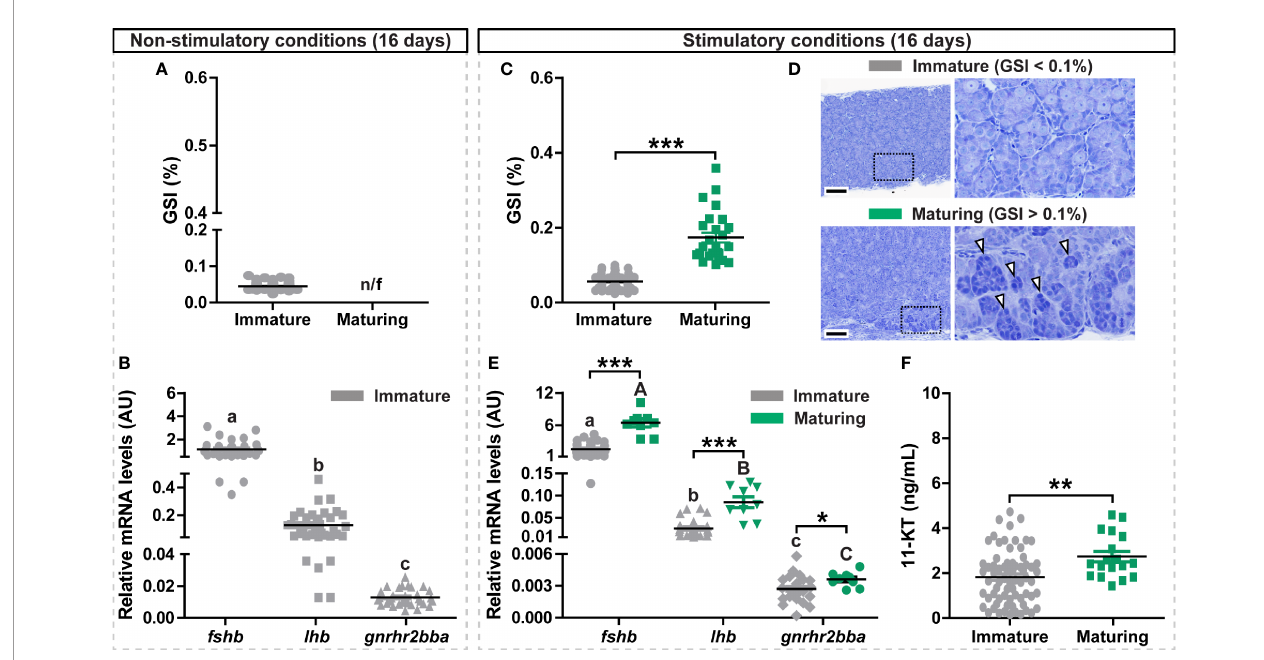
FIGURE 1 | Evaluation of gonadal and pituitary responses to non-stimulatory and stimulatory conditions. (A, B) Gonado-somatic index (GSI; A) and in vivo expression levels of selected pituitary genes ( fshb , lhb , gnrhr2bba ; B) in immature postsmolt males exposed to non-stimulatory conditions (12 hours dark/12 hours light, and 16°C) for 16 days. (C – F) GSI (C) , representative testis histology (D) , fshb , lhb , gnrhr2bba expression levels (E) and 11-ketotestosterone (11-KT) plasma levels (F) in immature and maturing males after exposure to stimulatory conditions (constant light and 16°C) for 16 days. In (A, C, F) , data are shown as mean ± SEM (N = 18-96; **p < 0.01; ***p < 0.001) and, in (B, E) , shown as mean ± SEM (N = 9-35; *p < 0.05; ***p < 0.001; different letters denote signi fi cant differences between groups) and expressed relative to the fshb mRNA abundance. n/f, not found. AU, arbitrary units. In (D) , boxes identify the testis tissue areas shown at higher magni fi cation, white arrowheads indicate representative groups of type B spermatogonia. Scale bar, 100